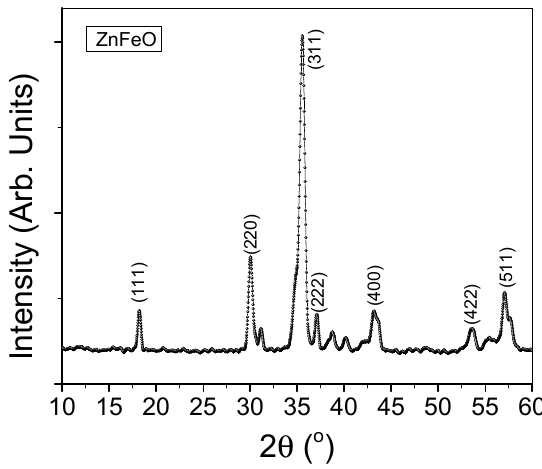
Figure 1. X-ray diffraction pattern of Zn-ferrite.